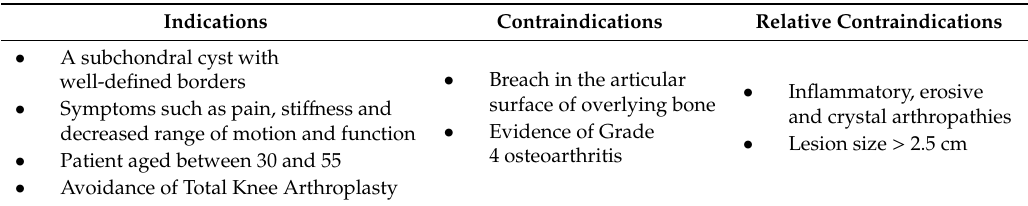
Table 1. Indications, Contraindications and Relative Contraindications of Intraosseous Bioplasty. Indications